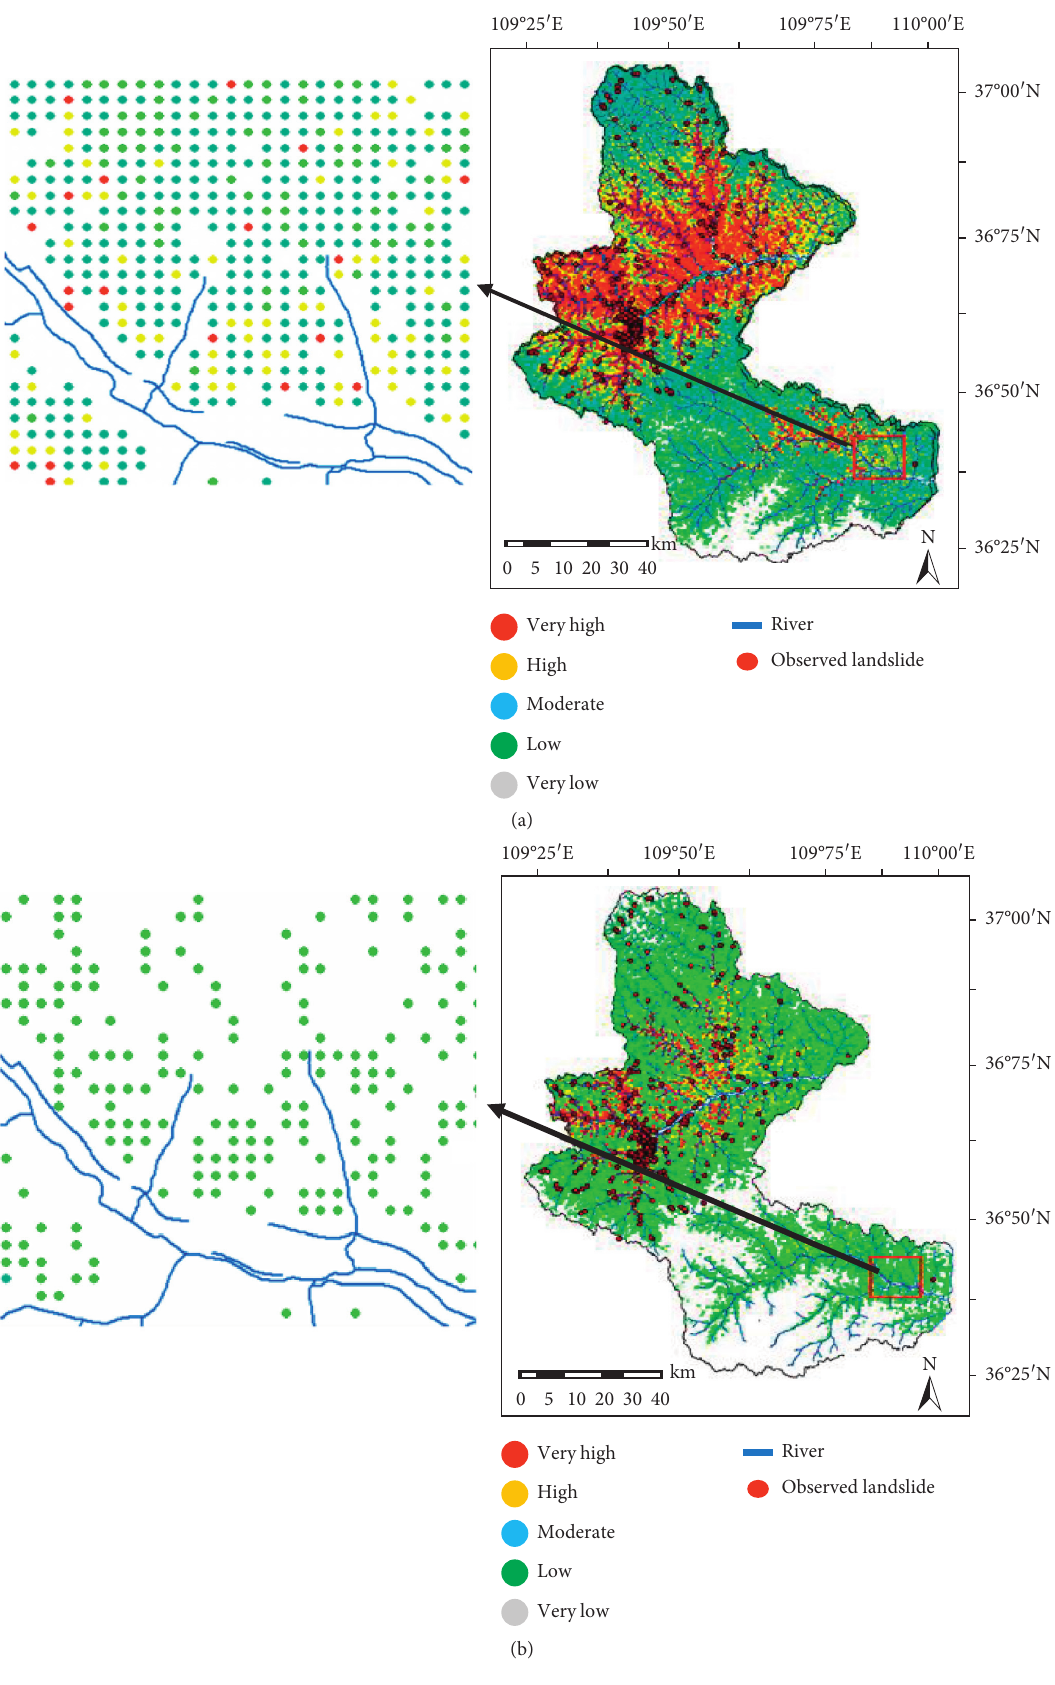
Figure 9: Assessment map of landslide susceptibility based on the CA-AQD algorithm: (a) April and (b)